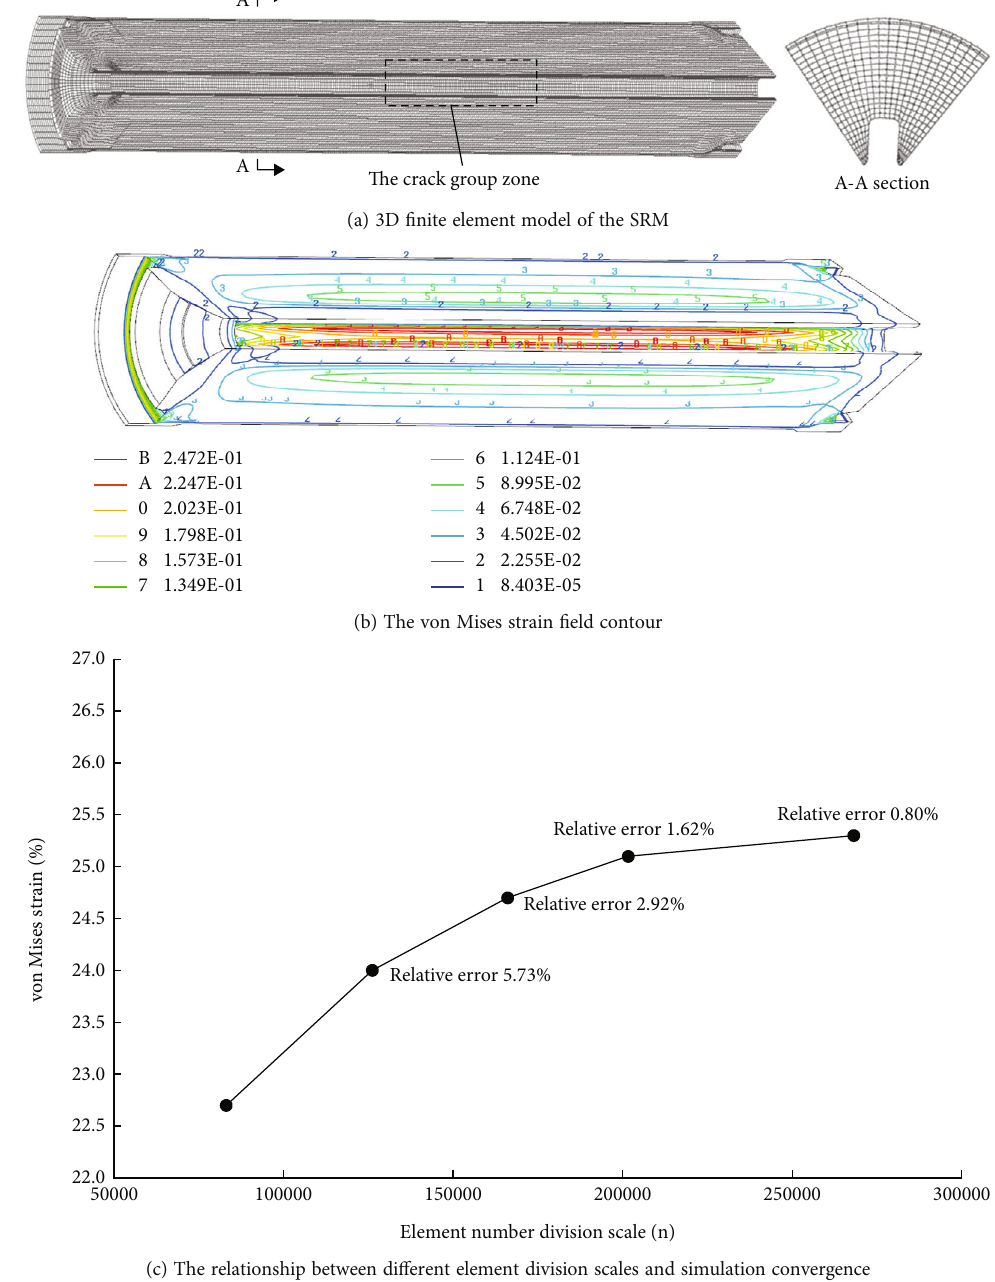
Figure 3: 3D fi nite element model and the von Mises strain contour of the SRM being